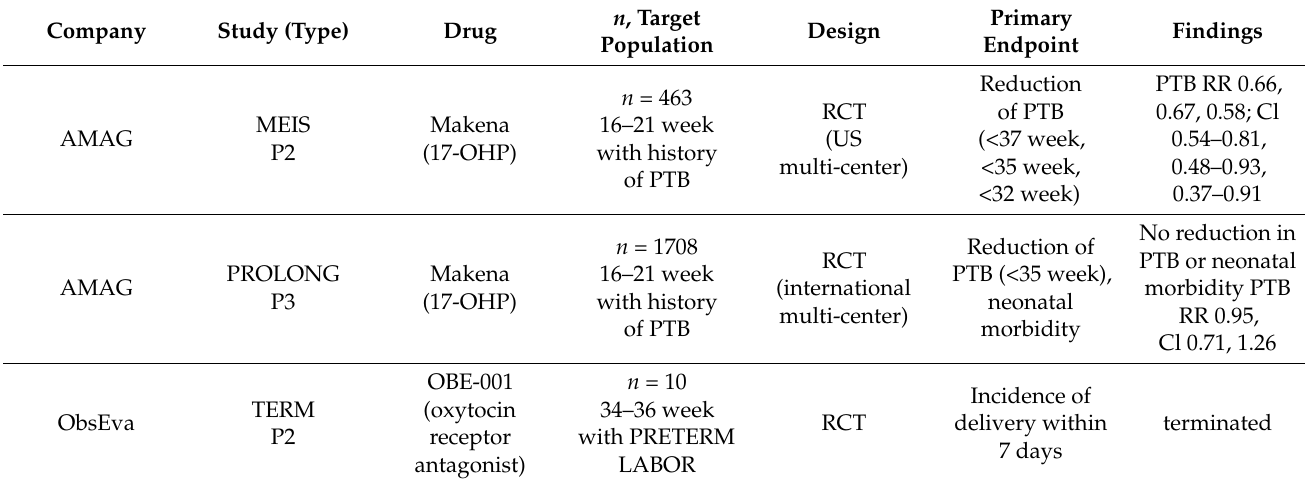
Table 2. Novel inflammatory therapeutics and ongoing clinical